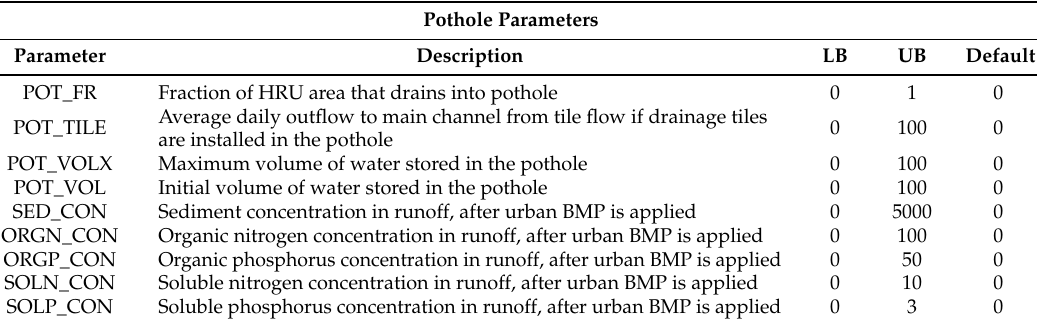
Table B1. Adjustable SWAT parameters for pothole functions.